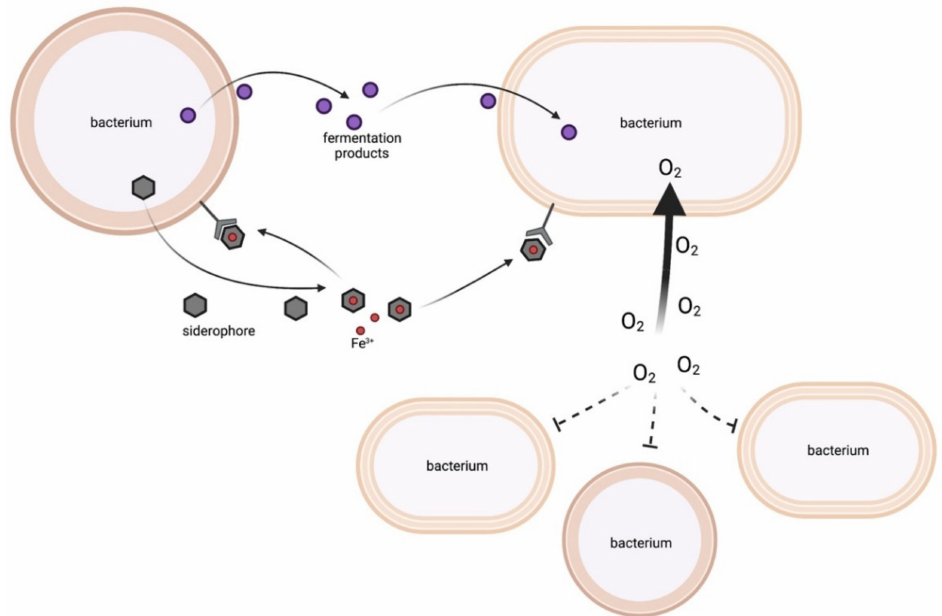
Figure 1. Production and consumption of small molecules. Bacteria can secrete fermentation products such as acetoin and 2,3-butanediol, which might support growth of another cohabitant bacterium. Siderophores bind iron (Fe 3+ ) and can be taken up not only by the producing bacterium but also by other bacteria with a matching receptor and transporter. Oxygen consumption by one species can relieve growth inhibition of anaerobic species. This figure was created with